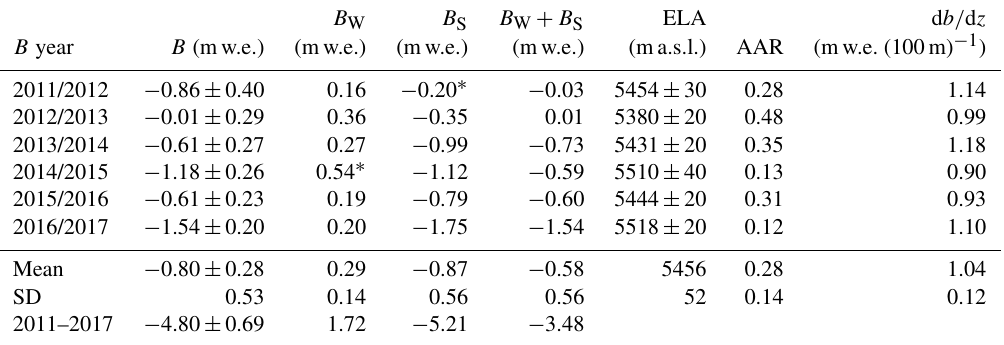
Table 2. Mass balance ( B ) measured with the glaciological method, winter balance ( B W ), summer balance ( B S ), ELA, AAR and mass- balance gradient for Yala Glacier from 2011/2012 to 2016/2017. The summer balance from 2011/2012 and winter balance from 2014/2015 ( ∗ ) have not been reported to the WGMS and are discussed in Sect. 5.1.2.